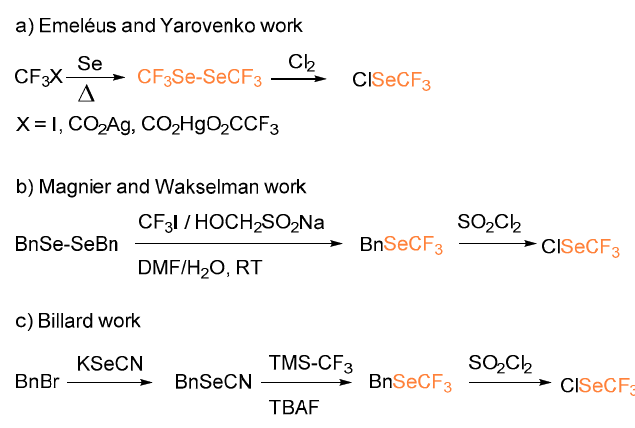
Scheme 1. Different approaches for the synthesis of trifluoromethylselenochloride.